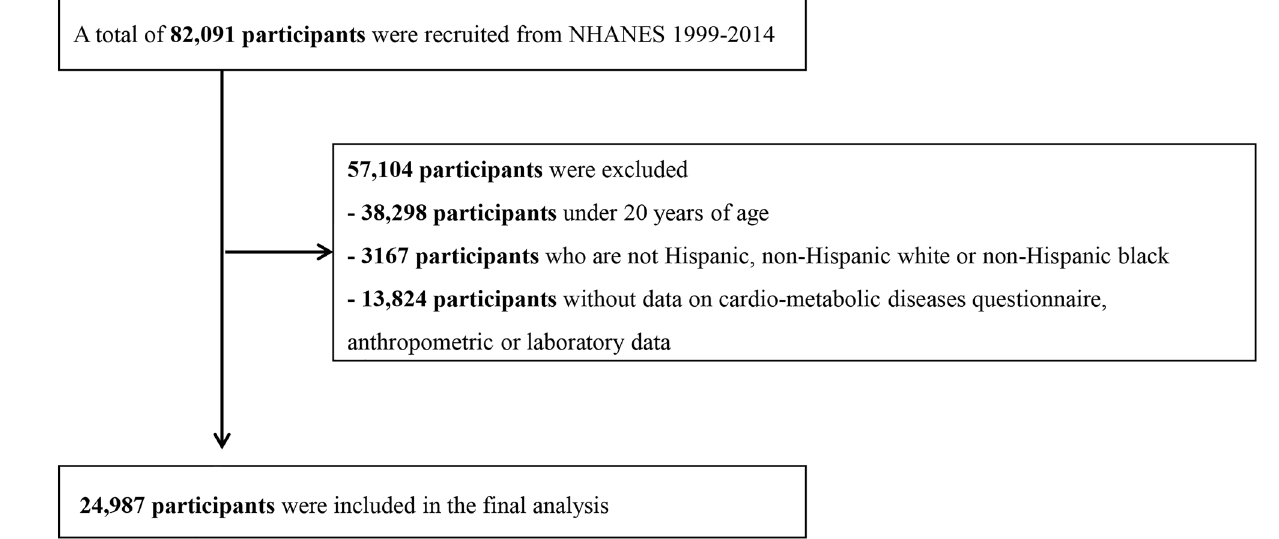
Figure 1. Flowchart for final